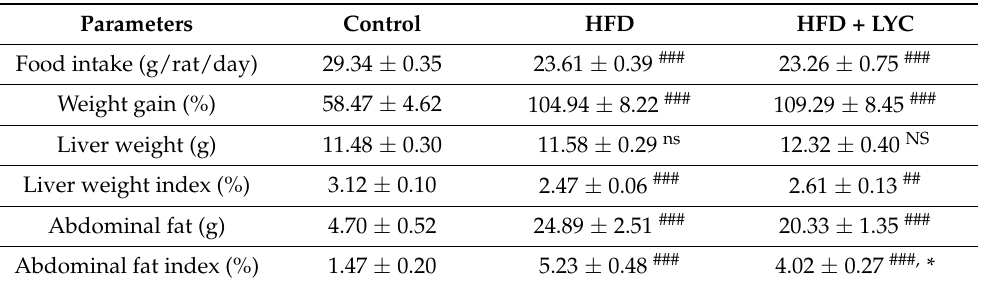
Table 1. Food intake, body weight gain, liver weight, liver index, abdominal fat, and abdominal fat index following treatment with LYC (HFD + LYC rats).